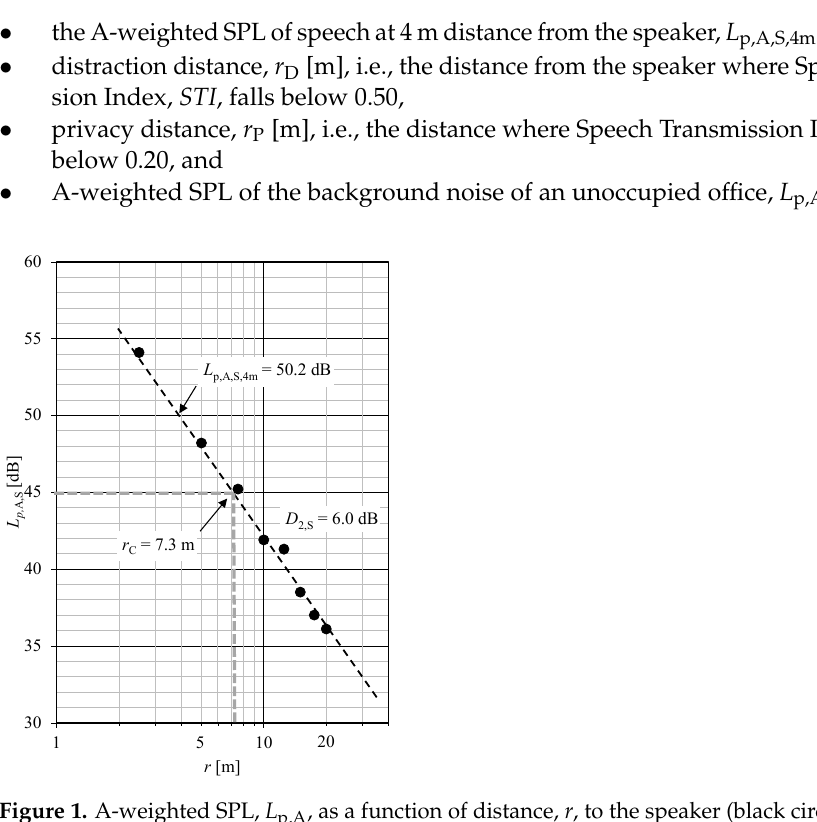
Figure 1. A-weighted SPL, L p,A , as a function of distance, r , to the speaker (black circles) and a linear fit over the data (dashed line). Definitions for D 2,S , L pA,S,4m , and r C are given in Section 1. The data is not related to this study.